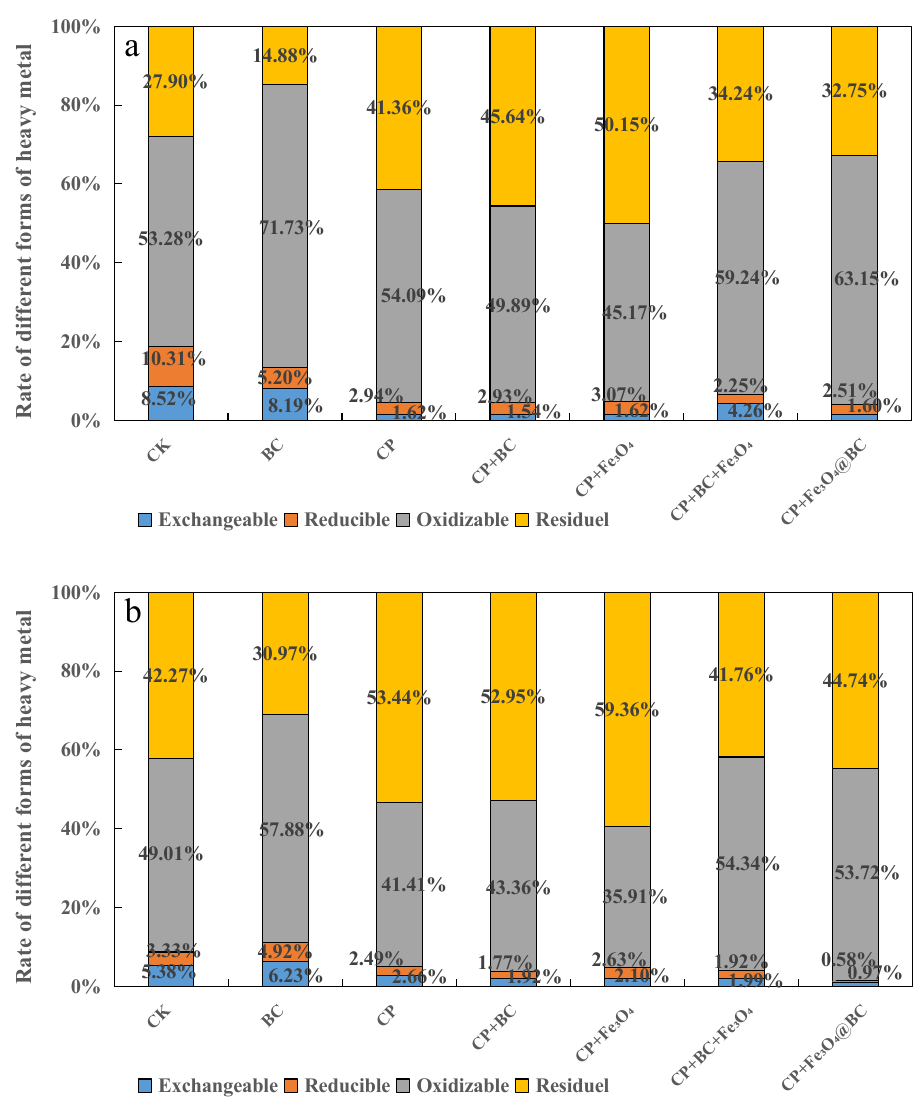
Figure 7. The variation of heavy metal Cr in different groups during the experimental study; ( a ) the 6th day; ( b ) the 25th day. Among them, the acid extractable state and the reducible state are unstable and easily release and migrate, which are the main fractions released into the water [36,37]. On the sixth day, the acid extractable state content of the CK group and the BC group was almost the same, accounting for about 8%, but the reducible state content was different at 10.31% and 5.20%, respectively. On the 25th day, the acid extractable state and reducible state in the CK and BC groups still remained at about 5%. However, the content of the acid extractable state and reducible acid in the CP+Fe 3 O 4 @BC group was 1.6% and 2.51% on the 6th day and decreased to 0.97% and 0.58% on the 25th day, respectively, which could greatly reduce the harm of Cr release and migration. The Cr content of different forms in different experimental groups can be seen in supporting materials Tables S3 and S4.